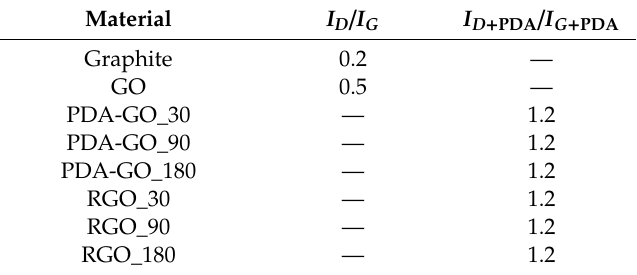
Table 2. I D / I G or I D +PDA / I G +PDA of the graphene derivatives.